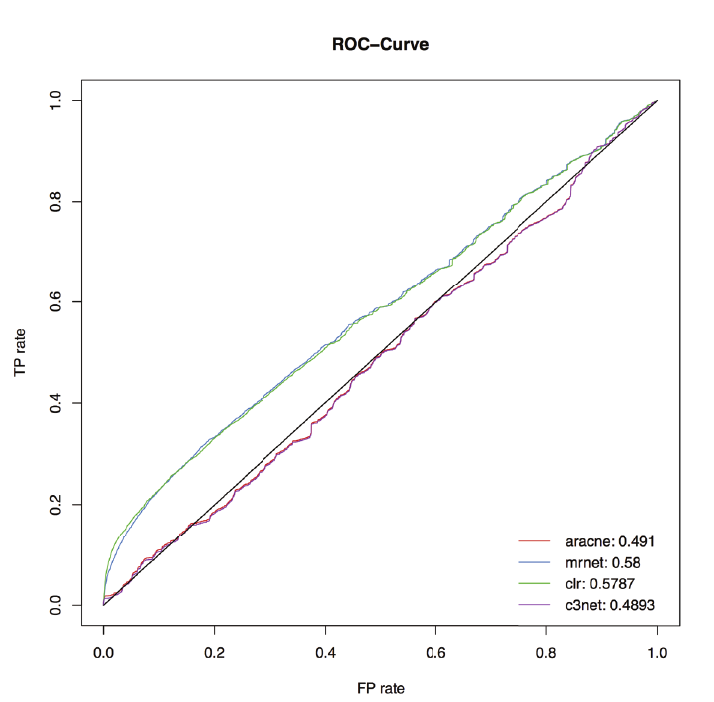
Figure 7. ROC with corresponding AUC for inferred GBM networks compared to BioGrid interactions using 2901 genes.